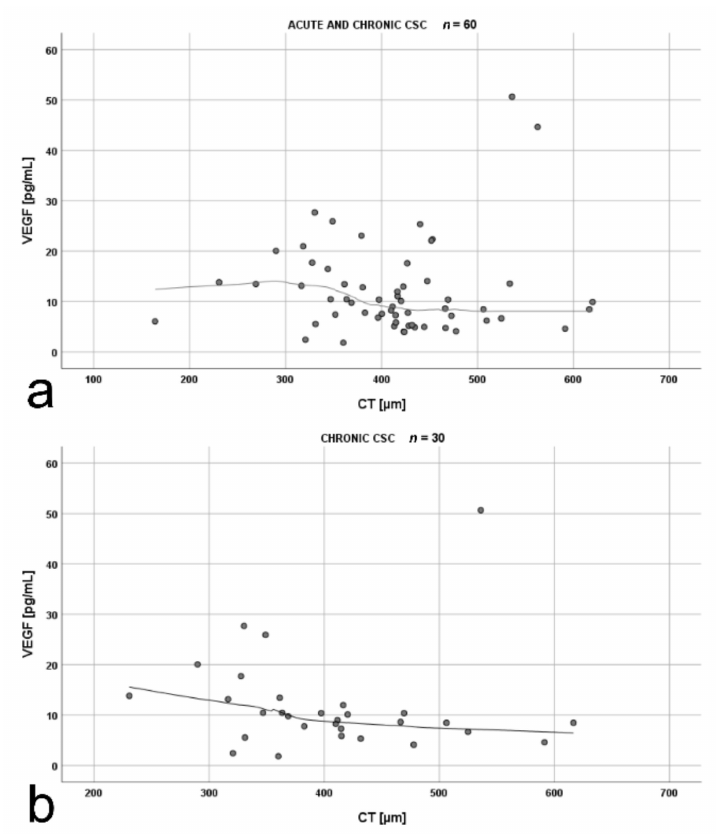
Figure 5. Scatterplots showing the correlations between: ( a ) mean choroidal thickness (CT) and vascular endothelial growth factor (VEGF) levels in patients with acute and chronic central serous chorioretinopathy ( rho = − 0.27, p = 0.044); ( b ) mean CT and VEGF levels in patients with chronic central serous chorioretinopathy ( rho = − 0.48, p = 0.009). The strength of the relationship between the variables was estimated using the Spearman rank correlation coefficient rho . The shape of the relationship was presented using the loess